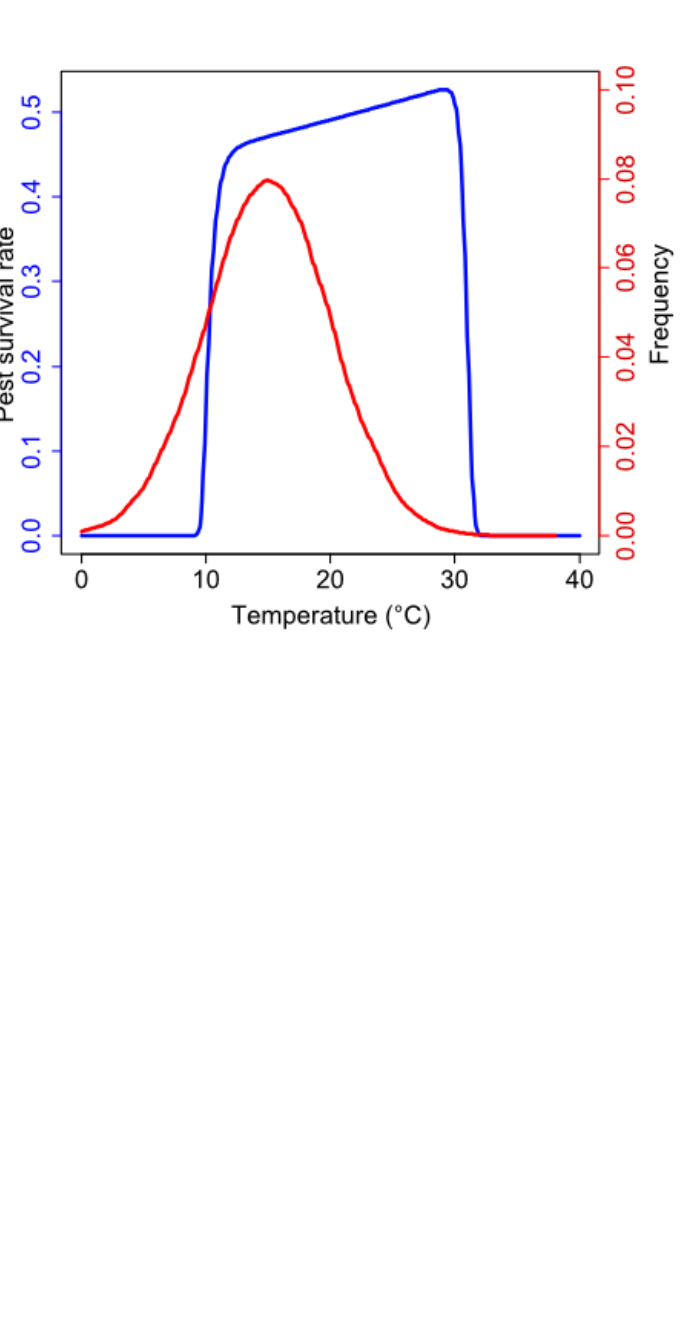
Fig. A1.1. Pest temperature dependant survival model, following Sharpe and DeMichele (in blue, see Crespo-Pérez et al. 2011 Supplementary material 1 for the model parameters), and temperature variability in our agent-based model (in red). Further sensitivity analyses demonstrated a linear response of farmers’ pest control to different degrees of variability in temperature (using a Gaussian distribution centered on 15 degrees and with a standard deviation ranging from 0 to